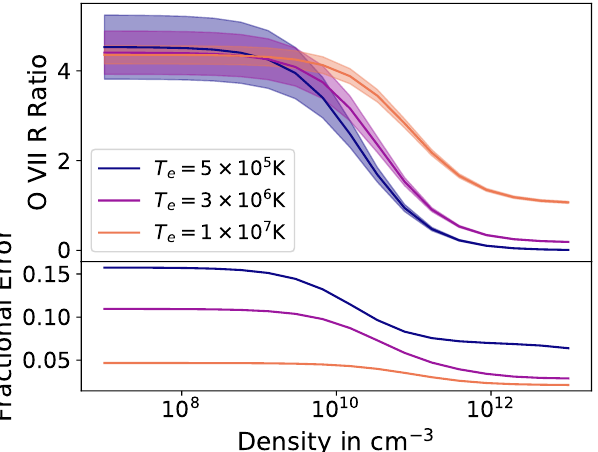
15% uncertainty on the direct excitation rates of the forbidden, resonance, Figure 5. O VII R ratio with a ± and intercombination lines at three different plasma temperatures.